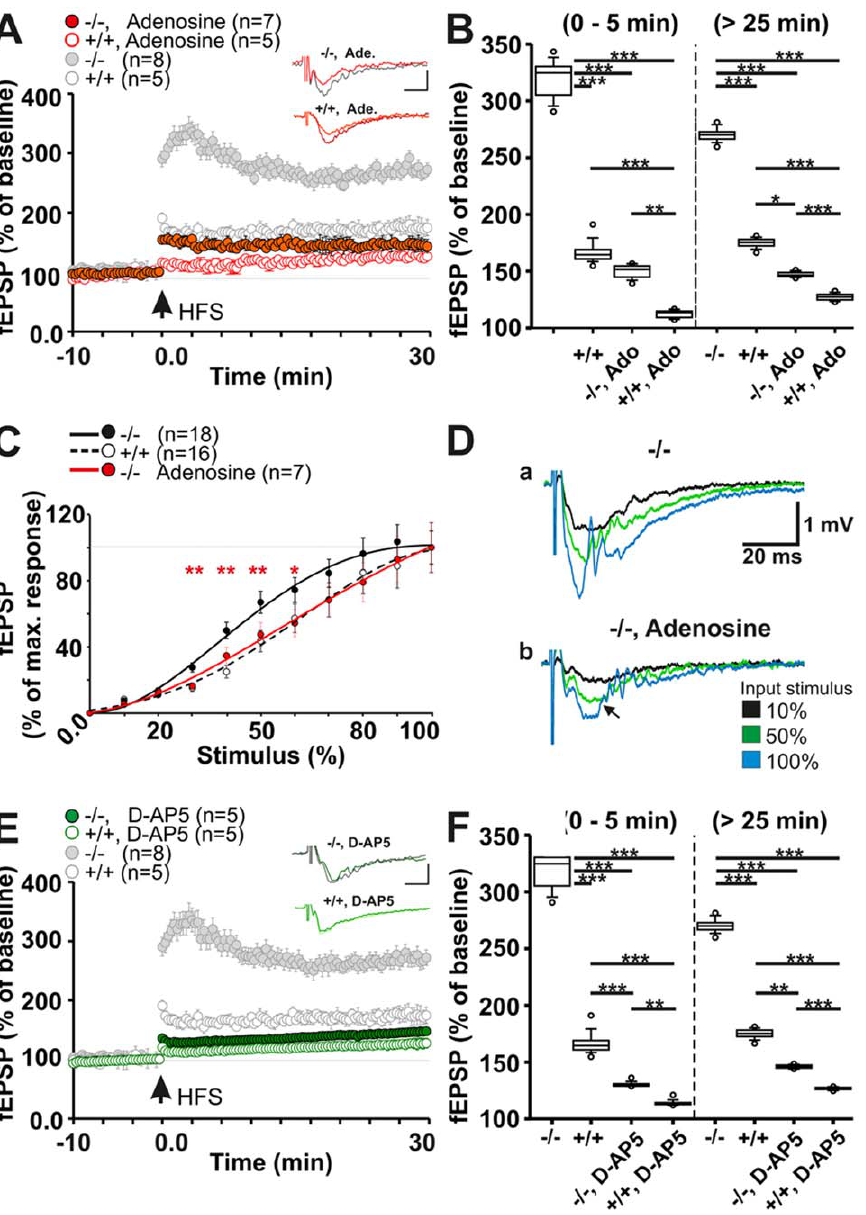
Figure 3. Pre- and postsynaptic components of altered Panx1 2 / 2 LTP. a, Evoked LTP in presence of 3 m M adenosine: Panx1 2 / 2 derived fEPSPs during early and persistent LTP phases are restored towards LTP levels of the untreated controls. Figure insets in (a) indicate 2 / 2 and + / + original responses under blocking conditions before and 30 min post HFS (scale horizontal: 10 ms, vertical: 0.5 mV). b, Comparison for early phase (0– 5 min) and persistent phase LTP (25–30 min). All conditions differ significantly from the Panx1 2 / 2 (see Figure 1). c, IO- correlation of the adenosine- treated Panx1 2 / 2 in comparison to Panx1 2 / 2 and Panx1 + / + under ACSF conditions. Adenosine treatment normalized the input sensitivity of the Panx1 2 / 2 towards values of the untreated controls (Panx1 + / + ). d, fEPSP sample traces of the Panx1 2 / 2 , revealing a decrease in oscillatory activity (arrow) and amplitudes. e, NMDA dependence of 2 / 2 and + / + derived LTP after application of 50 m M D-AP5. NMDA inhibition leads to decrease of the signal during early and persistent phase of LTP, as demonstrated in (f). f, All conditions differ significantly from the Panx1 2 / 2 . Statistics: (b) ANOVA (early: F3,64 =157.9; P , 0.0001; late: F3,64 =458.7; P , 0.0001), (f) ANOVA (early: F3,64 =184.9; P , 0.0001; late: F3,64 =547.4; P , 0.0001). doi:10.1371/journal.pone.0051767.g003 F (1,12) =1.28; P = 0.28; 72 dB: F (1,12) = 4.933; P , 0.05, One-way anxiety levels and sensor-motor gating capabilities. Three different pre-pulse intensities (64, 68, 72 dB) were tested in Panx1 2 / 2 (n =8) and Panx1 + / + mice (n =6) [27]. An impoverished reduction in the amplitude of the startle response was evident in Panx1 2 / 2 animals compared to Panx1 + / + controls at all intensities tested, with a statistically significant effect emerging at the intensity of 72dB (Fig. 5 A ; 64 dB: F (1,12) =1.037; P = 0.3285; 68 dB: